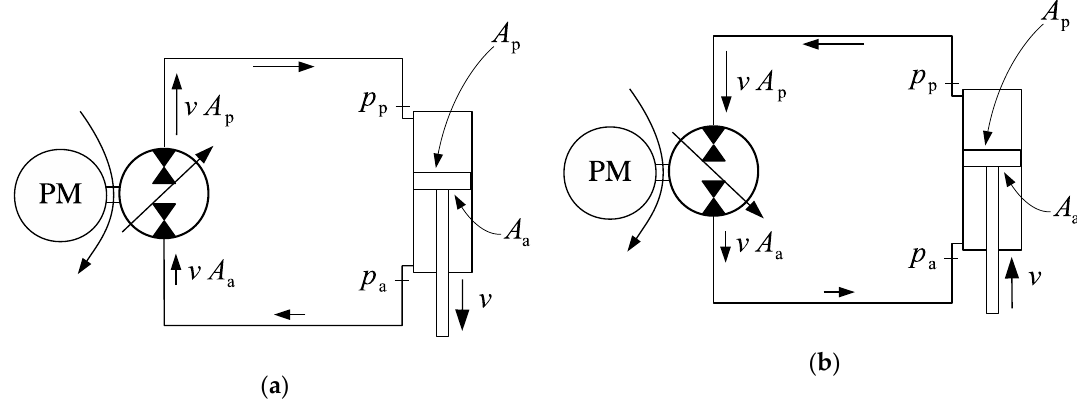
Figure 1. The problem of unmatched flows in single-rod actuators: ( a ) pump starvation during extension; ( b ) cap-side pump overflow during retraction.